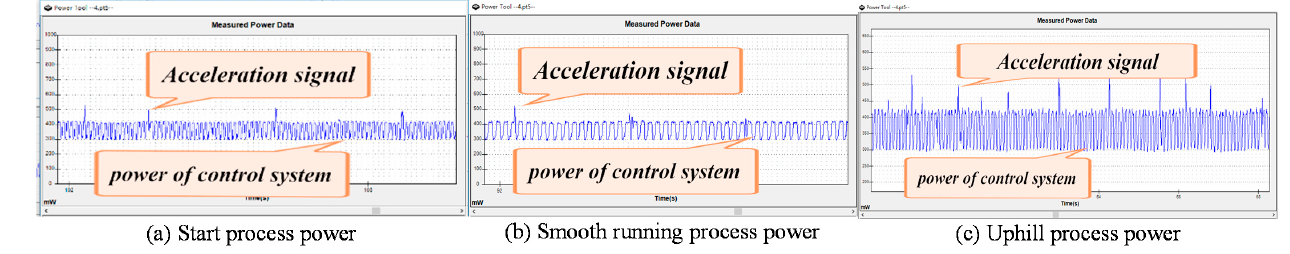
Figure 11. Power of the control system in different states of motion.